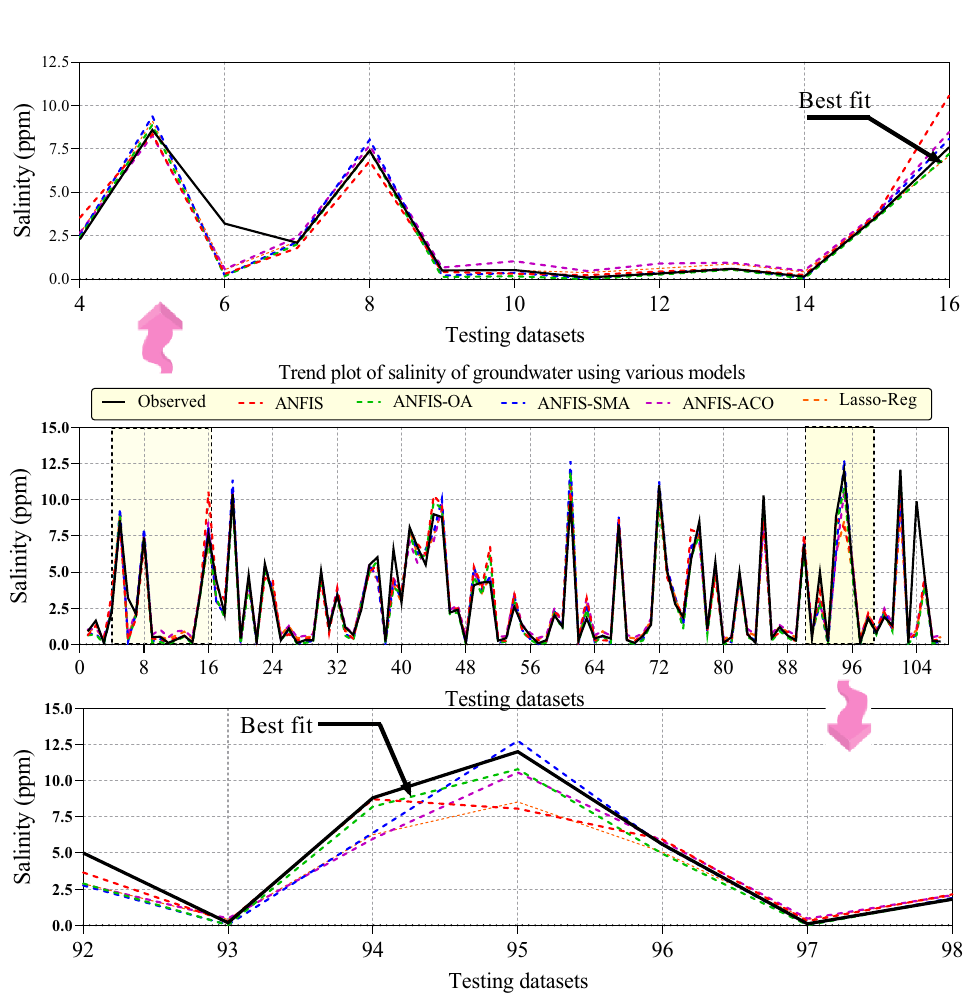
Figure 12. comparison between the observational and values of salinity of groundwater via the provided models in the optimal